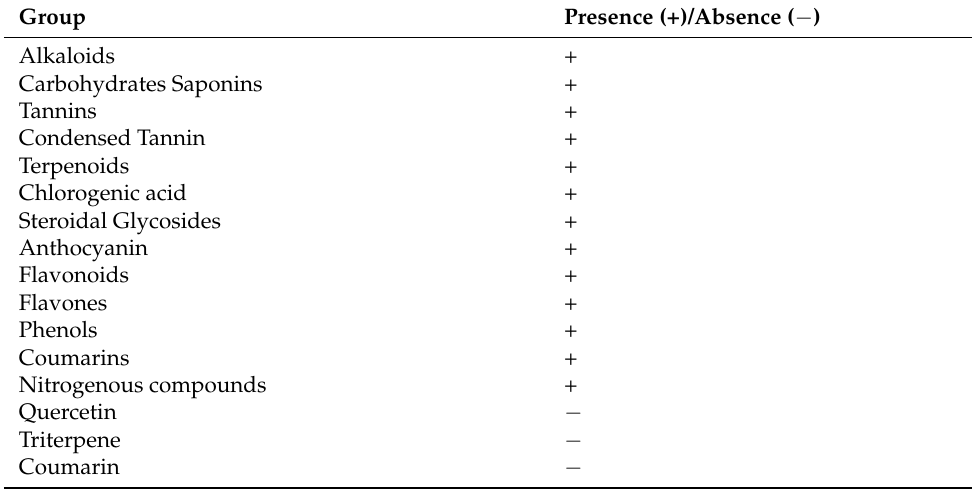
Table 1. Qualitative screening of GNME.